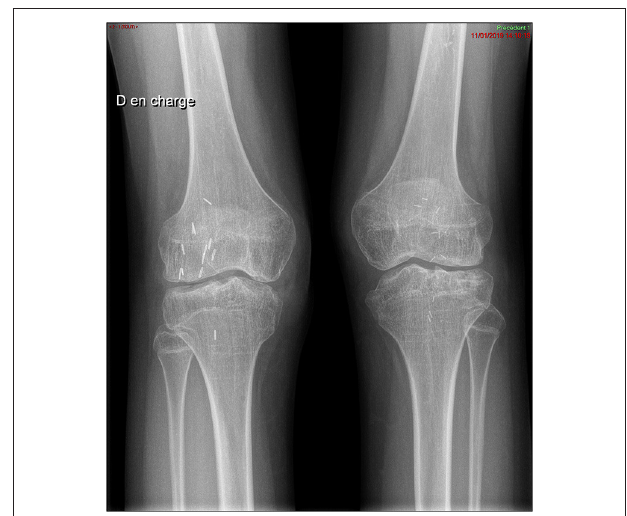
FIGURE 2 | Plain x-ray of the knees. Pancompartmental joint space loss reflecting secondary osteoarthritis changes, with presence of diffuse joint narrowing and subchondral